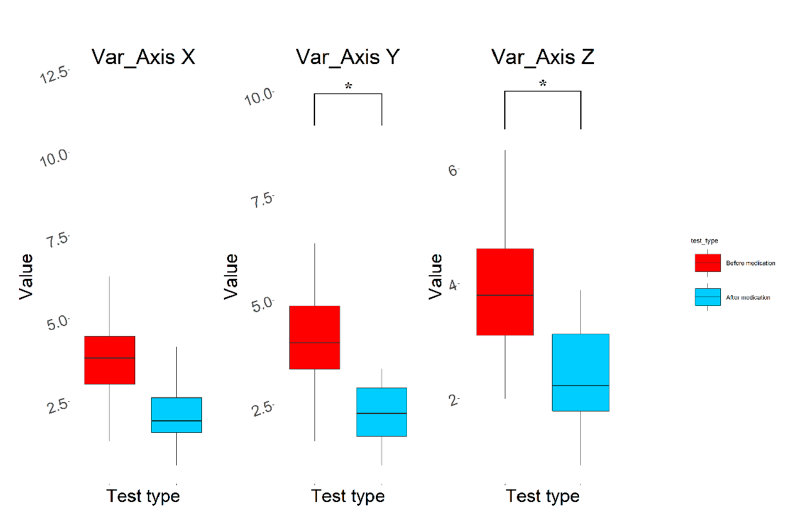
Figure 1. Reductions in variance values of accelerometer along three axes. Significant reductions of variance values of accelerometer along the y- and z-axis after 1 month of medication use in patients with ADHD. * p < 0.05/3 = 0.0167.